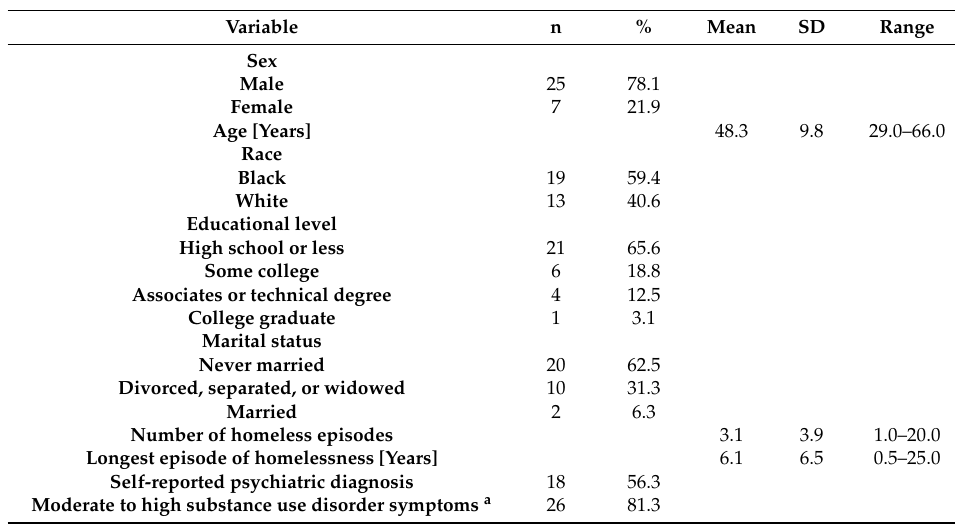
Table 1. Participant characteristics at baseline (N = 32).